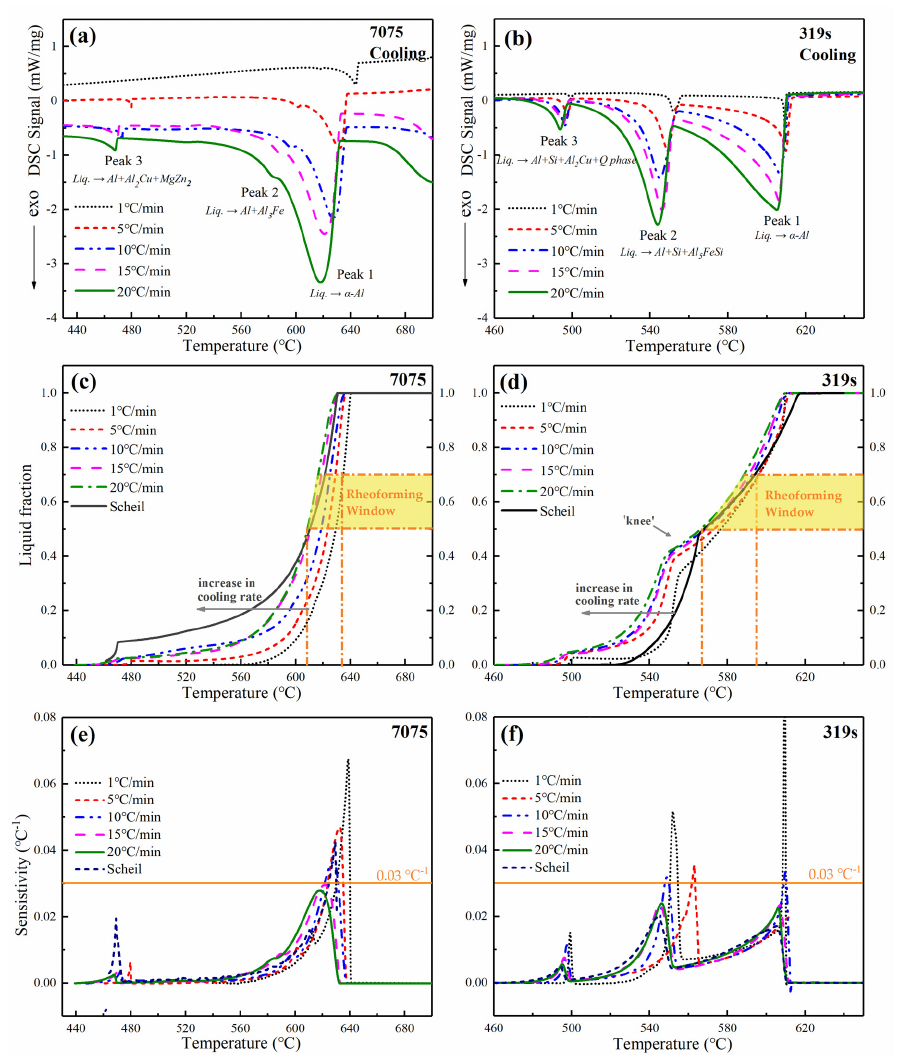
Figure 1. Measured DSC signal of 7075 ( a ) and 319s ( b ) alloys at di ff erent cooling rates, calculated liquid fraction curves of 7075 ( c ) and 319s ( d ) alloys, the temperature sensitivity of 7075 ( e ) and 319s ( f ) alloys. Table 1. Rheoforming windows and solidification ranges for the 7075 and 319s alloys.